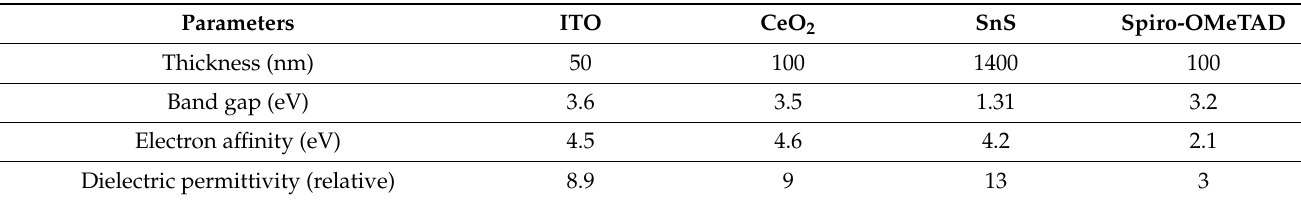
Table 1. Physical parameters of ITO/CeO 2 /SnS/Spiro-OMeTAD/Mo heterostructure solar cell. Parameters ITO CeO 2 SnS